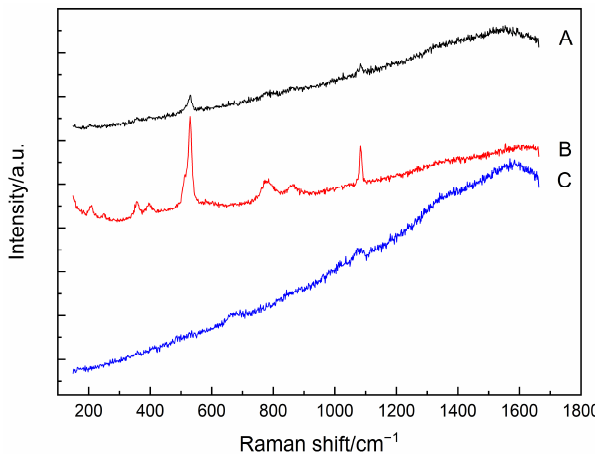
Figure 5. Raman spectra of the analyzed points (A–C) as shown in Figure 4.